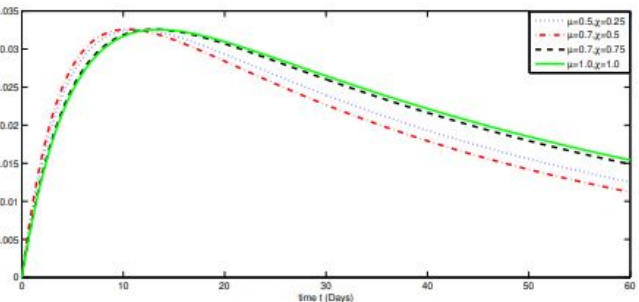
Figure 10. Graphs of numerical solutions at different fractal-fractional order for Exposed class.